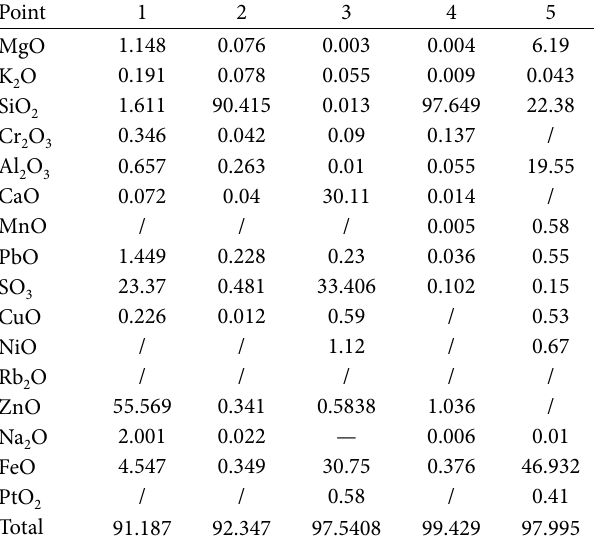
Table 2: Chemical composition of the electron probe points for the minerals (%).